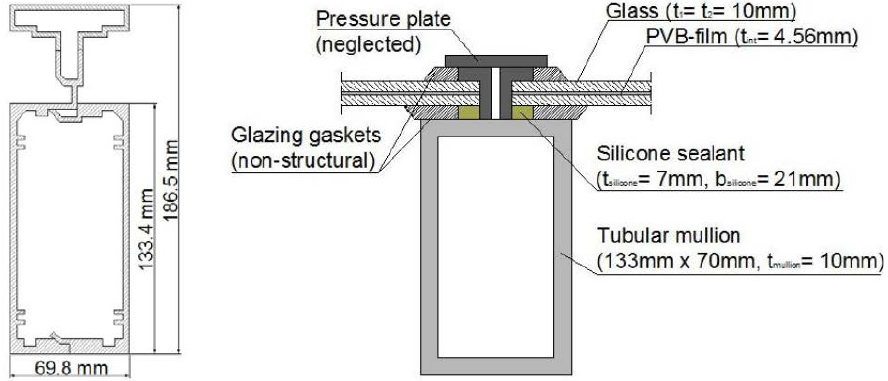
Figure 2. Cross section of a split screw spline mullion and example of idealized connection with glass panes.